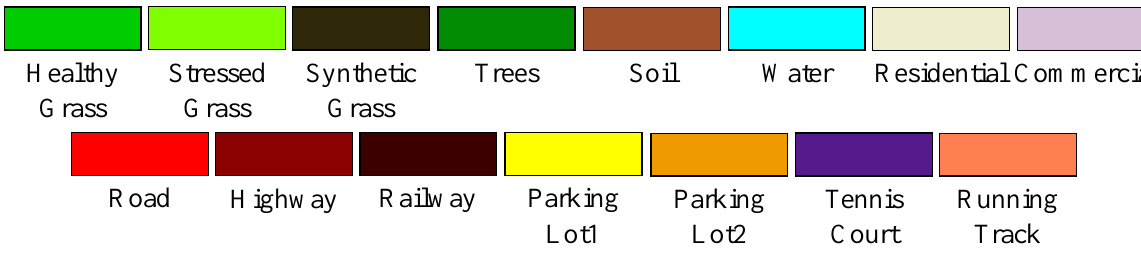
Figure 5. Classification maps obtained by CNN classifiers combined with the proposed methods on the 2012 Houston dataset.